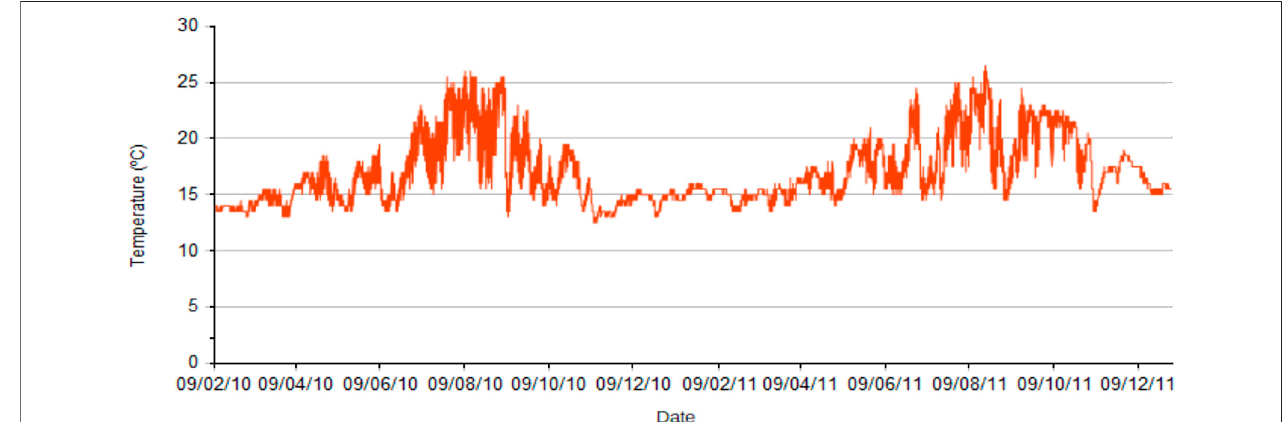
FIGURE 2 | Water temperature at 16 m in the Punta de la Mona between February 2010 and December 2011.